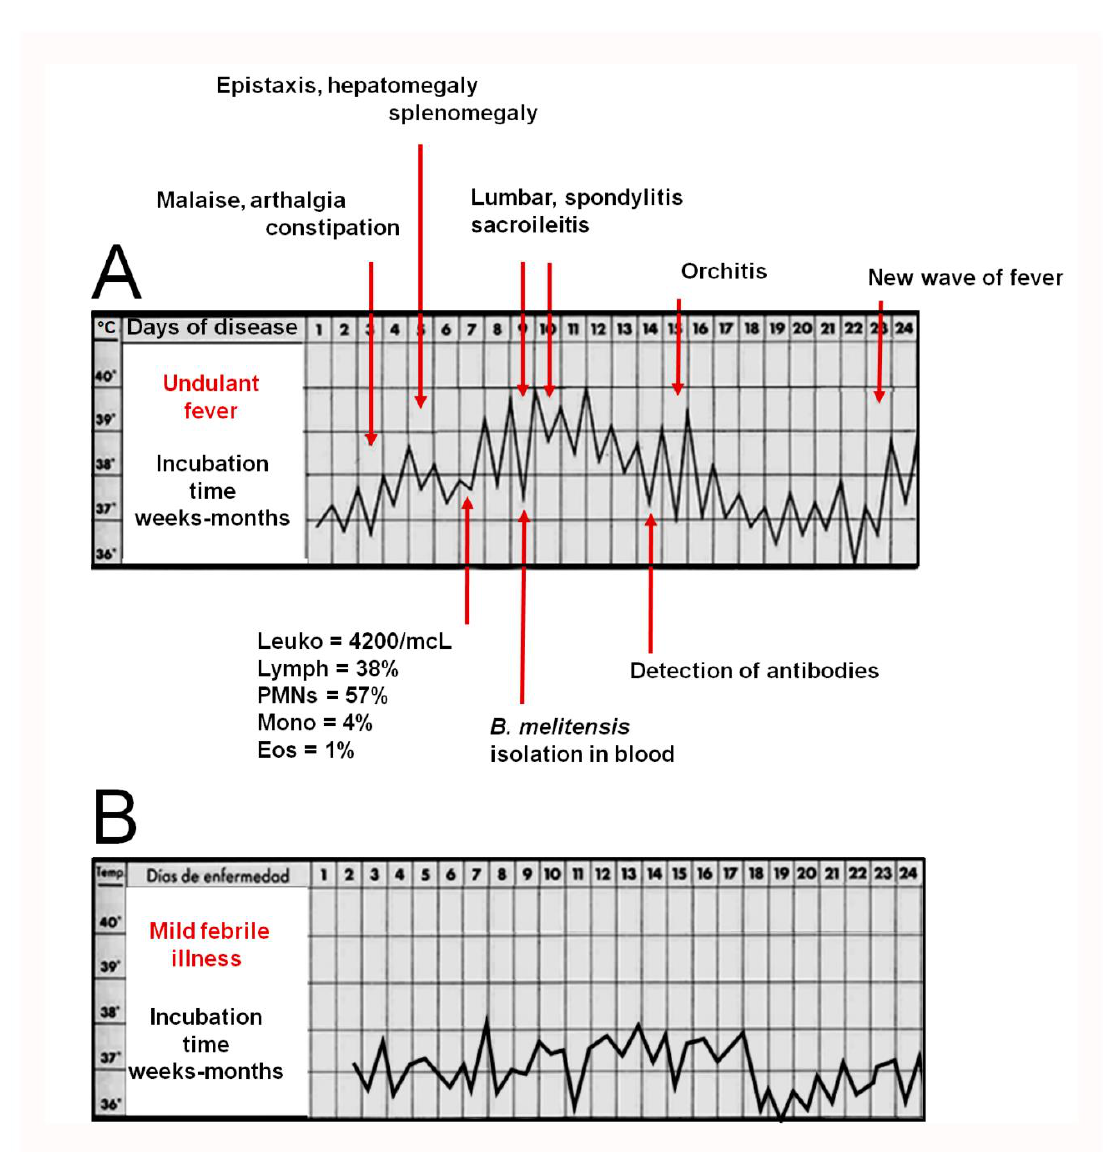
Figure 2. Clinical charts of two human brucellosis cases. ( A ) clinical chart displaying the “undulant fever” temperature of a brucellosis patient with subsequent clinical symptoms and signs. ( B ) Clinical chart of a brucellosis patient displaying mild febrile illness. Adapted from Reference [9].